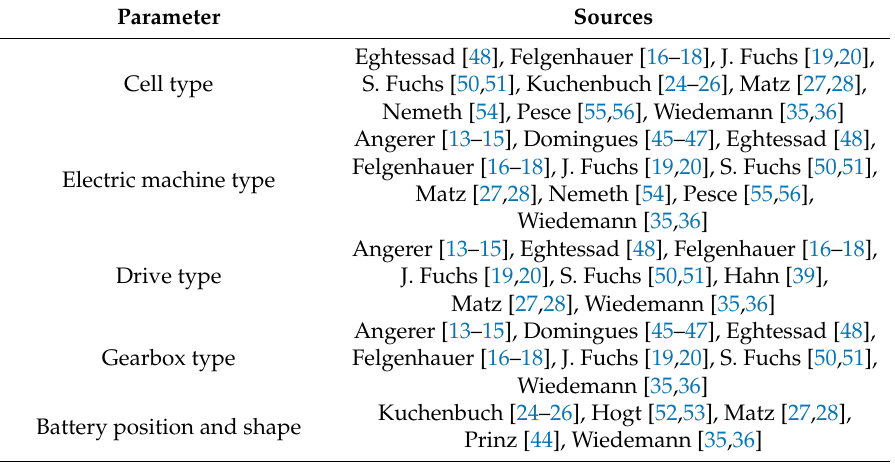
Table 3. Overview of the design parameters for the powertrain